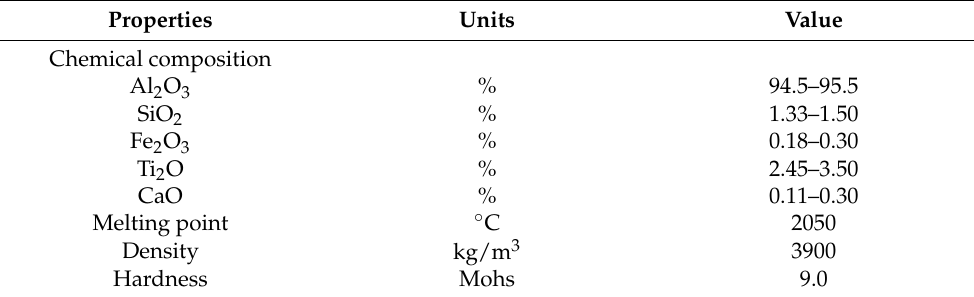
Table 2. Detailed properties of corundum